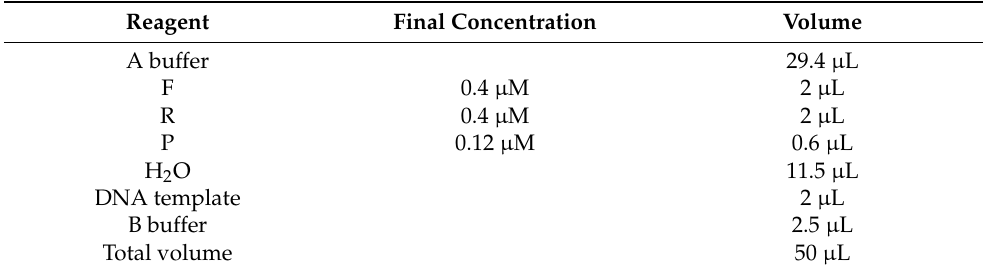
Figure 3. Primer-probe concentration optimization. Table 5. Fluorescence RPA detection reaction system.